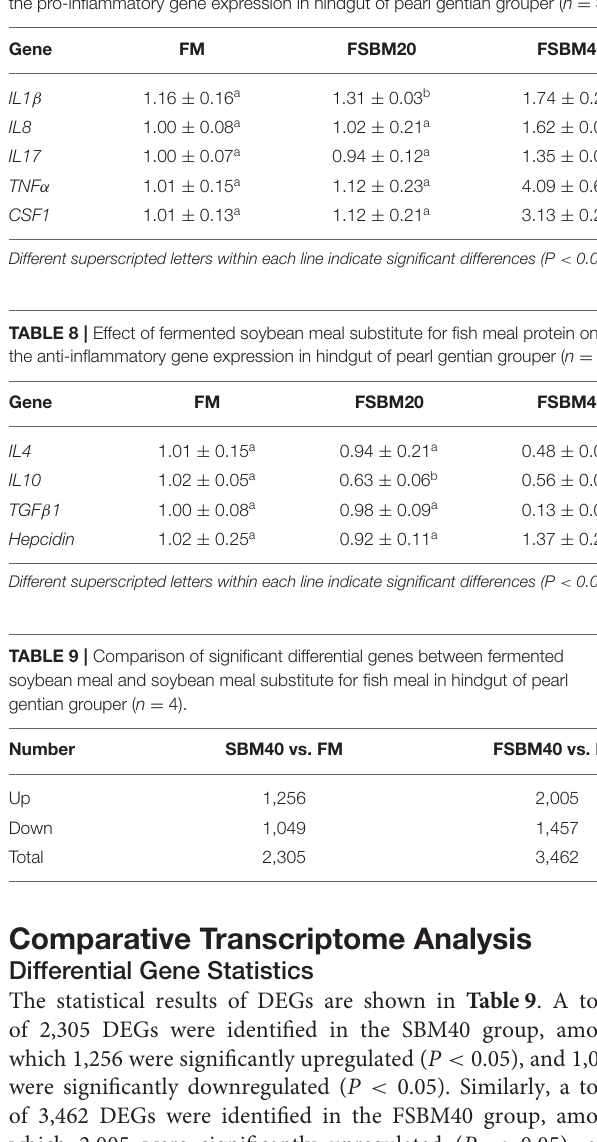
TABLE 7 | Effect of fermented soybean meal substitute for fish meal protein on the pro-inflammatory gene expression in hindgut of pearl gentian grouper ( n = 3).